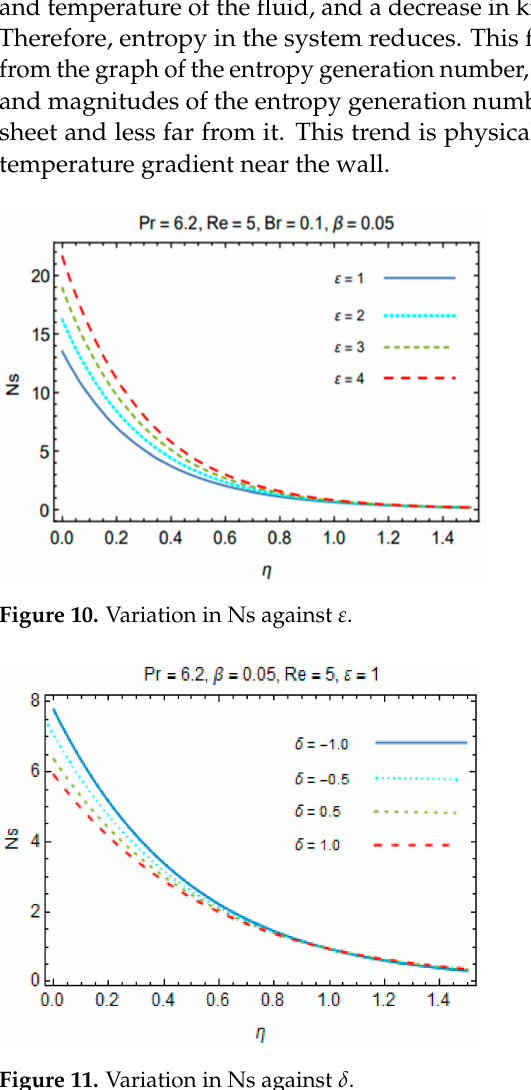
Figure 11. Variation in Ns against δ